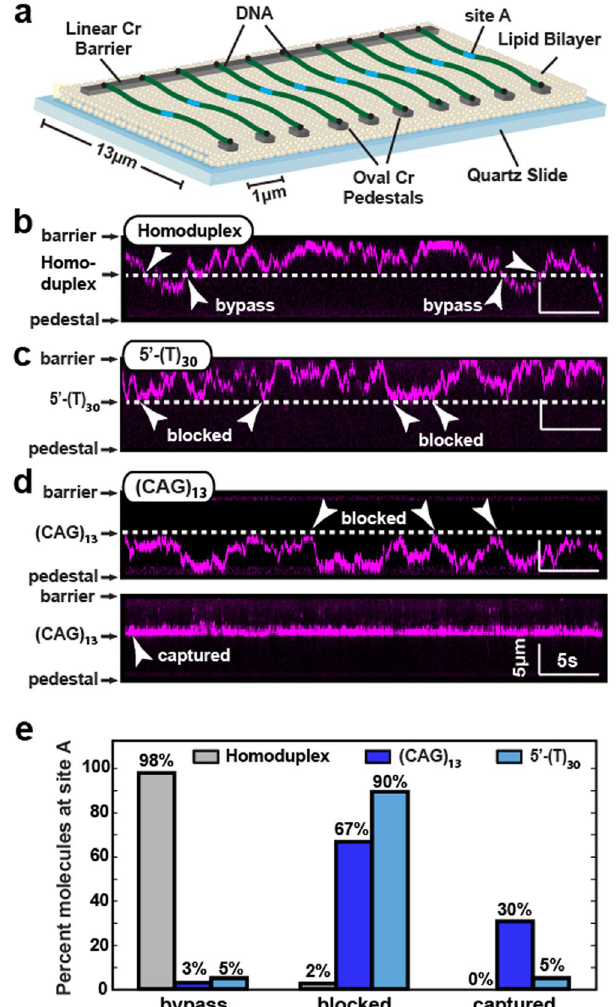
Figure 5. yPCNA diffusion on λ -DNA containing various extrahelical structures. ( a ) An illustration of the double-tethered DNA curtains. Chromium (Cr) pedestals are coated with anti-digoxigenin antibodies, and buffer flow is used to immobilize the dig-labeled λ -DNA between the linear barriers and Cr pedestals. Kymograph of diffusing yPCNA molecule on DNA substrates with ( b ) homoduplex DNA ( c ) a 5 ′ -ssDNA flap or a (CAG) 13 repeat ( d ). The characteristic changes in diffusion behavior of yPCNA are indicated with arrows, and the dashed lines indicate site A. ( e ) Percentage of molecules showing either bypass, blocked, or captured behavior at site A. At least 35 DNA molecules were analyzed and classified into each of three categories (N = 40, 36, and 40 for the flap, (CAG) 13 , and homoduplex DNA